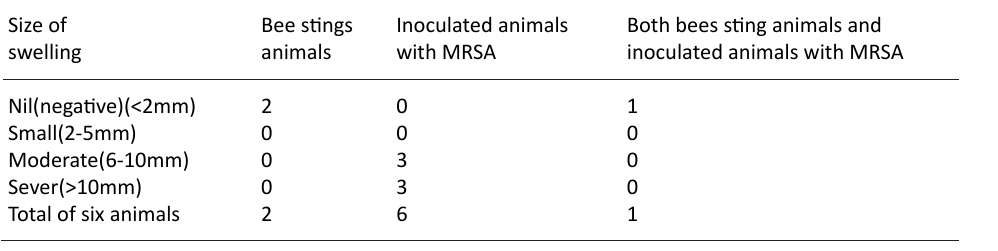
Table 1. Appearance of swelling on the skin of the six adult rabbits after stings with honey bee venom and subcutaneous inoculation with MRSA. Size of Bee stings Inoculated animals Both bees sting animals and swelling animals with MRSA inoculated animals with MRSA 2 0